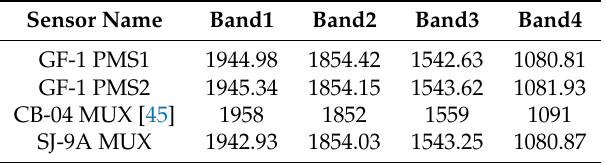
Table A1. Exo-atmospheric irradiance used in the experiment (W × m − 2 × µ m − 1 ).